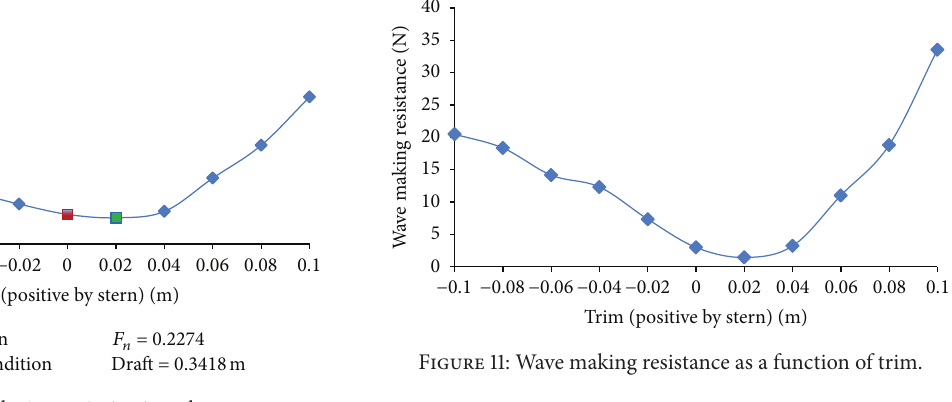
Figure 9: KCS hull trim optimization plot.